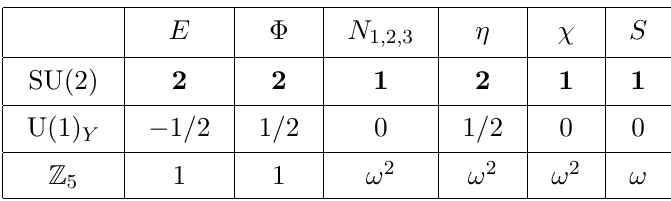
(cid:0) (cid:1) T (cid:23) ‘ (cid:0) is (cid:0) (cid:1) 2 (cid:25)i= 5 is the quintic root of unity.